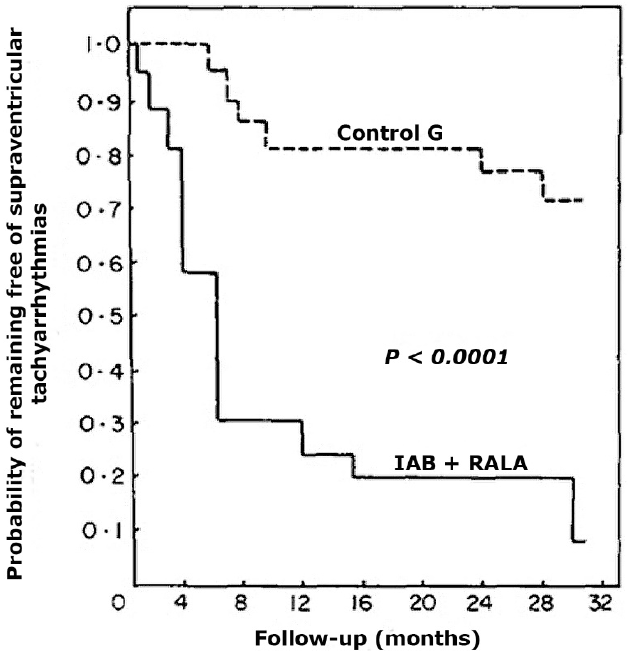
Figure 7. Probability of remaining free of supraventricular tachyarrhythmias (atrial flutter and atrial fibrillation) in patients with advanced interatrial block (IAB) and controls (partial IAB). (Take from reference 13).